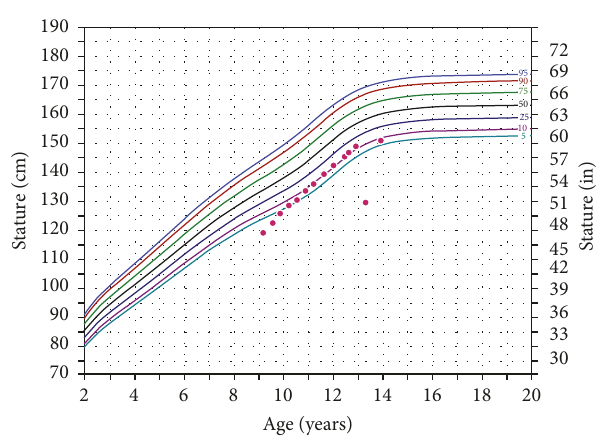
Figure 3: Height growth chart for Case 3